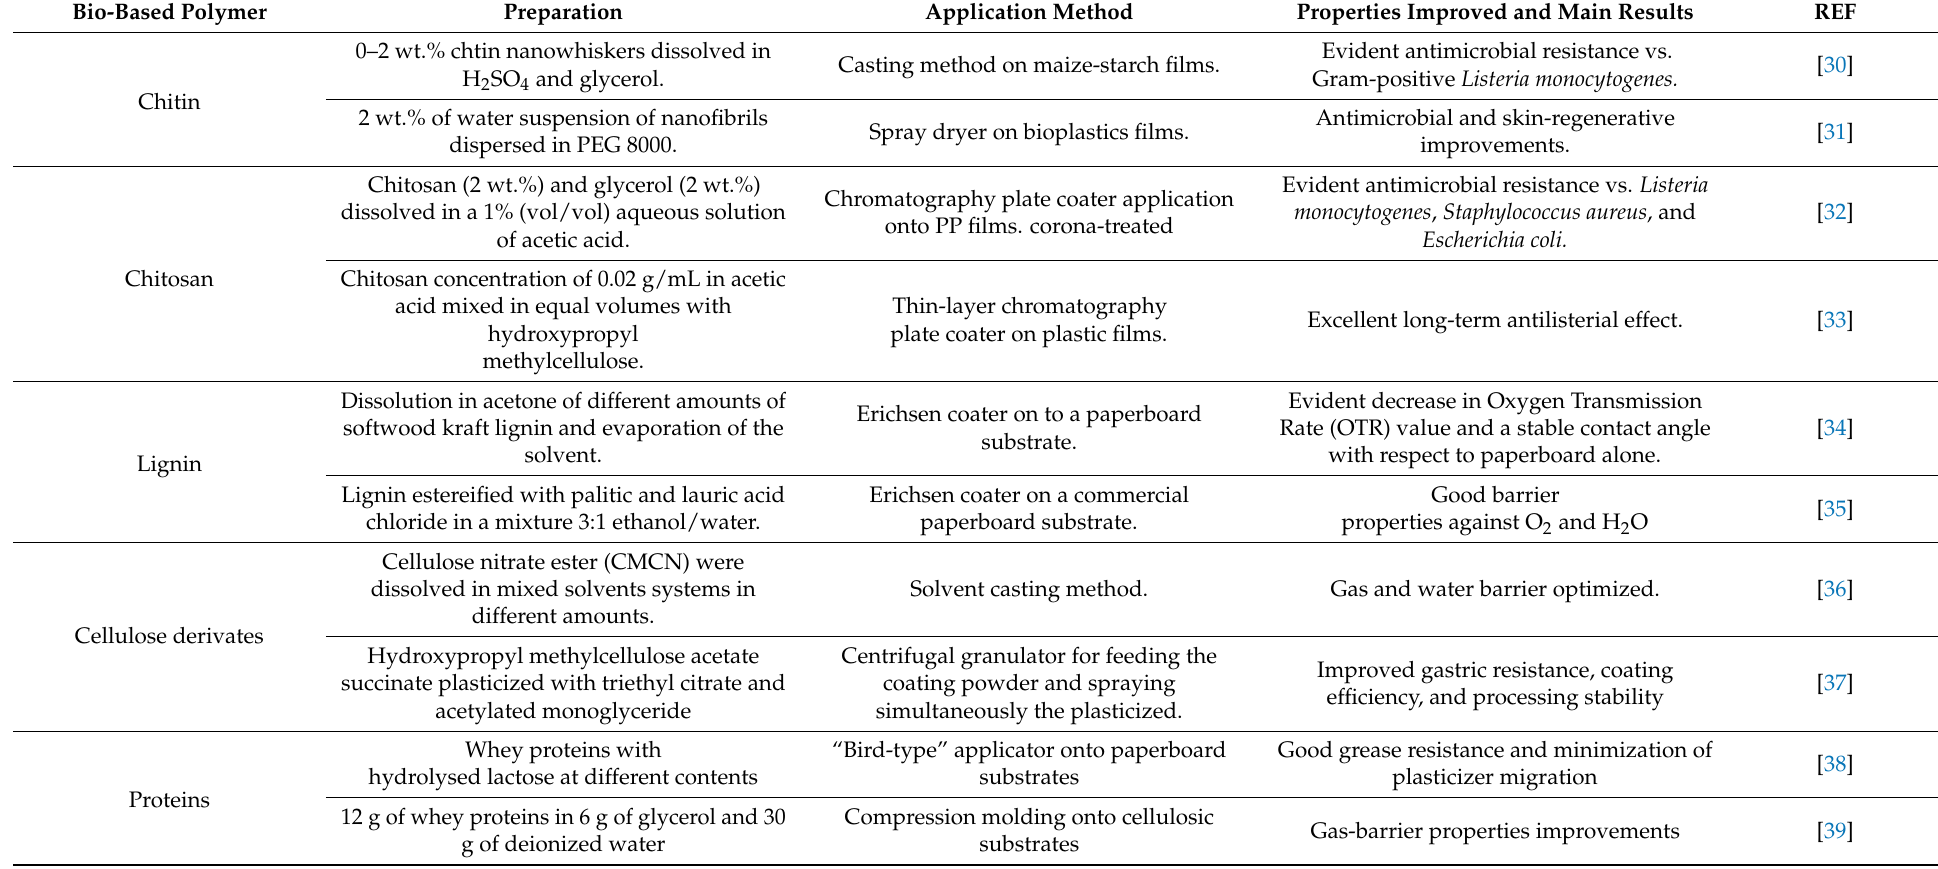
Table 1. Brief overview of biomolecules mostly used for coating